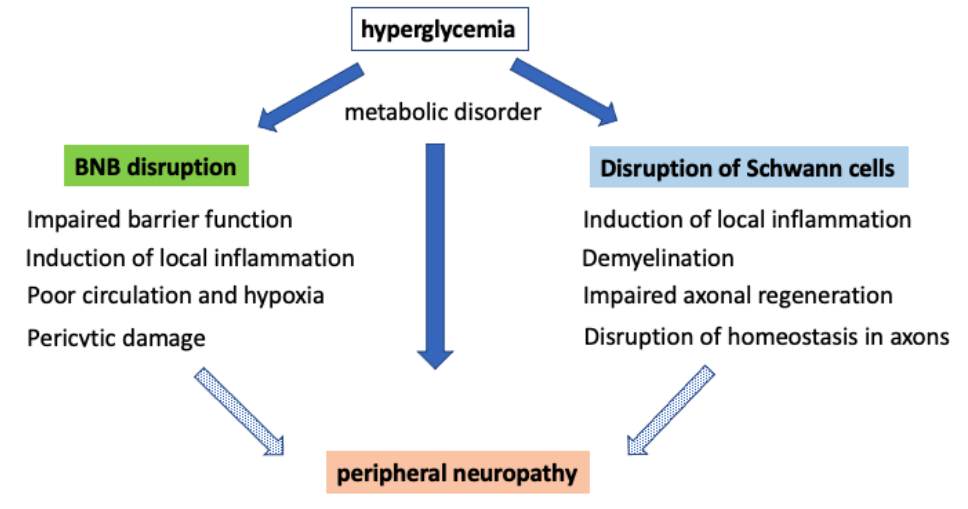
Figure 7. The pathological mechanism of neuropathy in diabetes mellitus. Hyperglycemia affects the Figure 7 BNB, Schwann cells, and peripheral nerves. BNB disruption has been confirmed to be associated with various pathological conditions: (1) impaired barrier function by accumulation of cytotoxic high-molecular-weight proteins, (2) induction of vasculitis and the progression of neuropathy due to induced local inflammation, (3) progression of neuropathy due to poor circulation and hypoxia, and (4) disruption of the regulatory mechanism of the BNB due to damaged pericytes. In Schwann cells, metabolic disorder induces the development of peripheral neuropathies such as demyelination, disruption of axonal homeostasis, and impaired axonal regeneration due to the destruction of myelin. Finally, disruption of the BNB and Schwann cells induced clinical types of peripheral neuropathy: (1) symmetric polyneuropathy due to metabolic disorder and (2) focal or multifocal neuropathy due to vascular